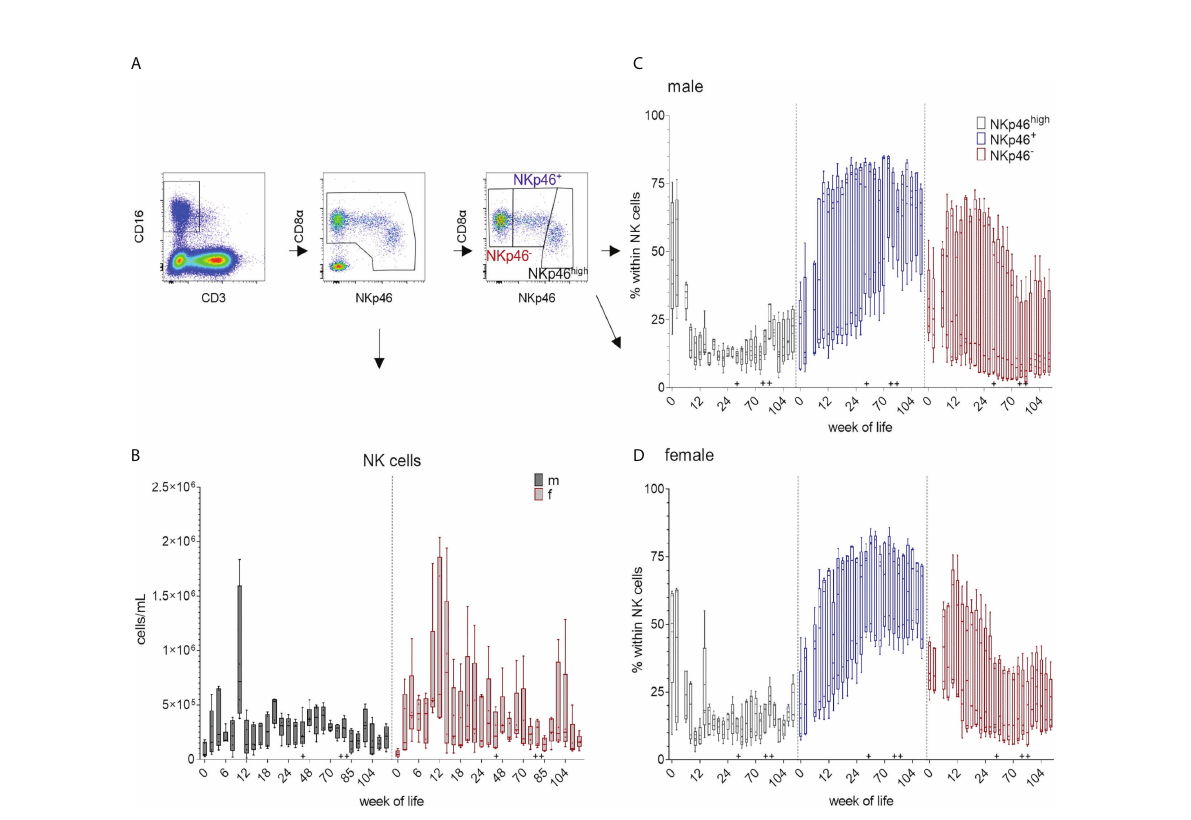
FIGURE 4 Total number of NK cells and their differentiation over the study period of 126 weeks. Total NK cell numbers were calculated based on the percentages of CD3 - CD8 a + CD16 + cells in total lymphocytes measured by FCM. (A) shows the gating strategy for a representative EGM (male, 18 weeks of age) for the determination of NK cells and the CD8 a /NKp46-de fi ned subsets. (B) Development of total NK cell numbers over time using CD3 - CD8 a + CD16 + expression. Sexes are represented by black (male) and red colors (female). Phenotypic analyses of the NK-cell subsets by the expression of CD8 a and NKp46 highlighted by different colors. CD8 a dim/+ NKp46 high (black), CD8 a + NKp46 + (blue), and CD8 a + NKp46 - (red). Relative changes in the composition of the NK-cell subsets over time are presented for males (C) and females (D) . + marks the fi rst bleeding time point after transfer and vaccination, ++ marks the fi rst bleeding time point after booster